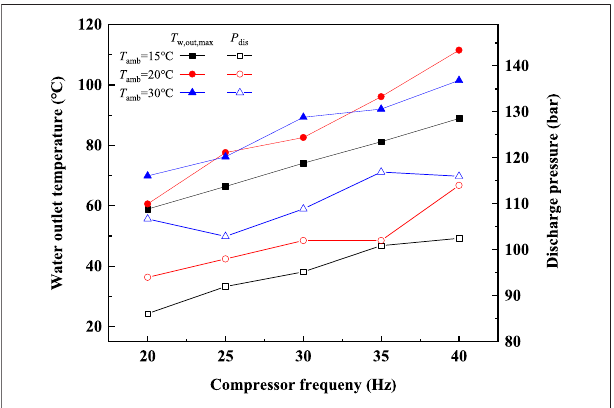
FIGURE 15 | Maximum GCW and the corresponding discharge pressure at different compressor frequencies and ambient temperatures.